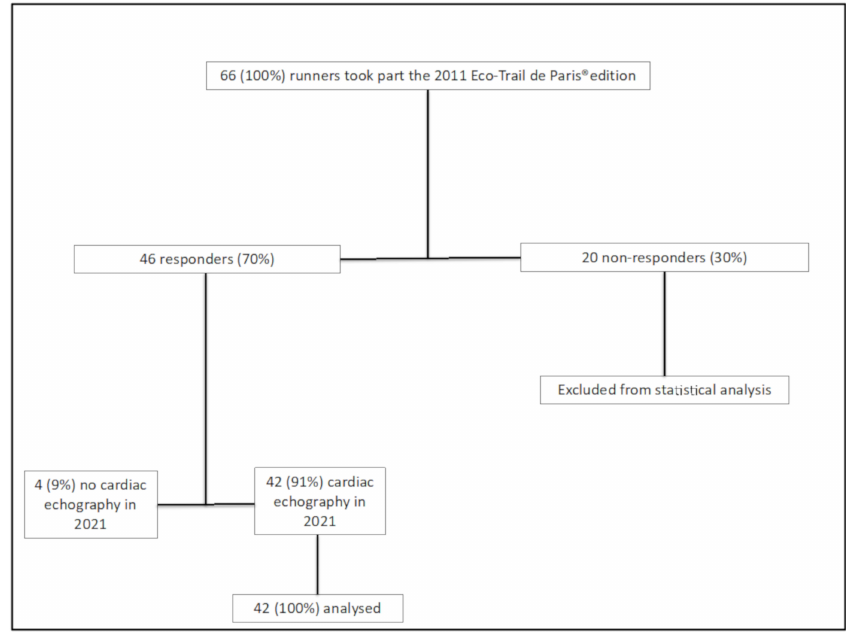
Figure 1. Study flow chart of the 66 participants involved in the 2011 Eco-trail de Paris ® edition that were contacted by